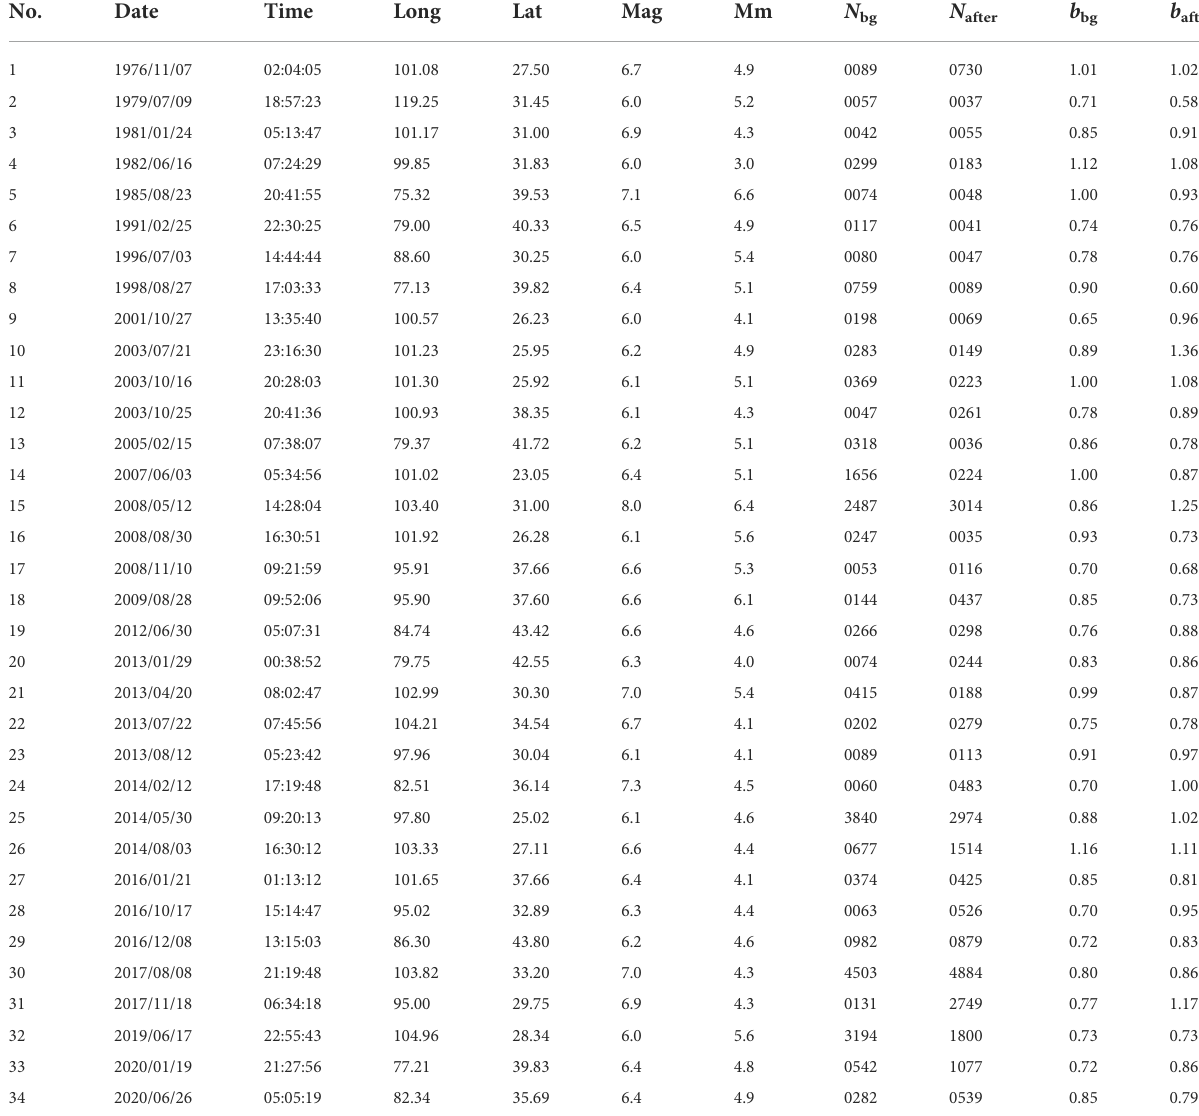
TABLE 1 Sequence parameters of intraplate earthquakes built for the SATLS in the China continent.